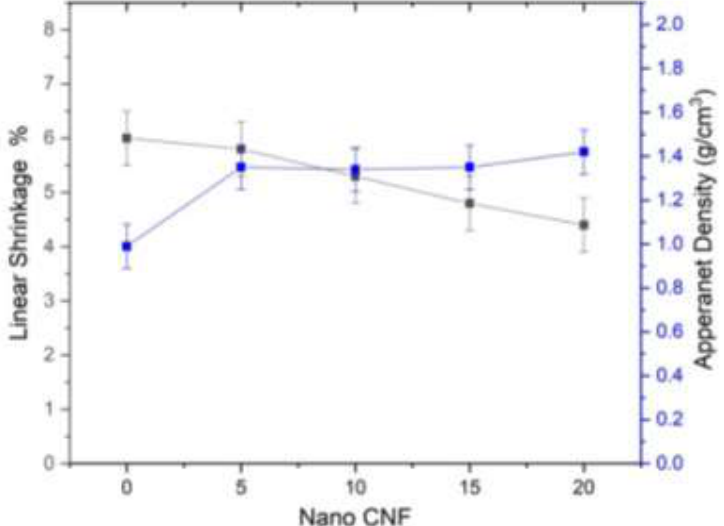
Figure 5: Effects of CNF ratios on the Linear Shrinkage and apparent density of